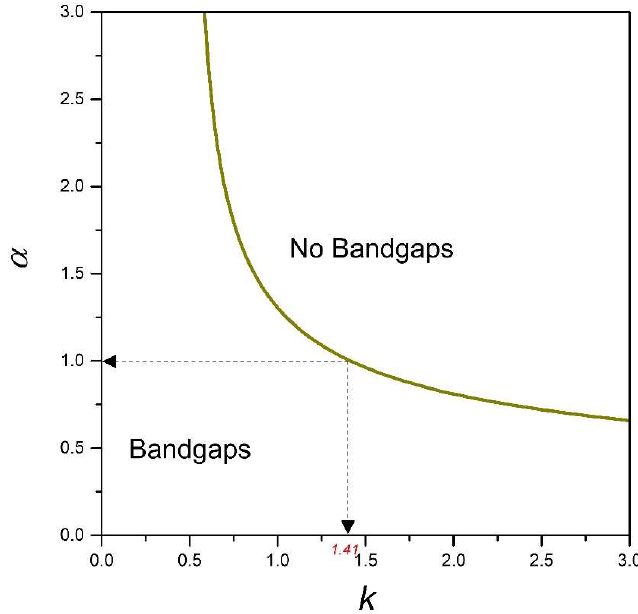
Figure 3. A phase diagram of the lattice material of Figure 1.